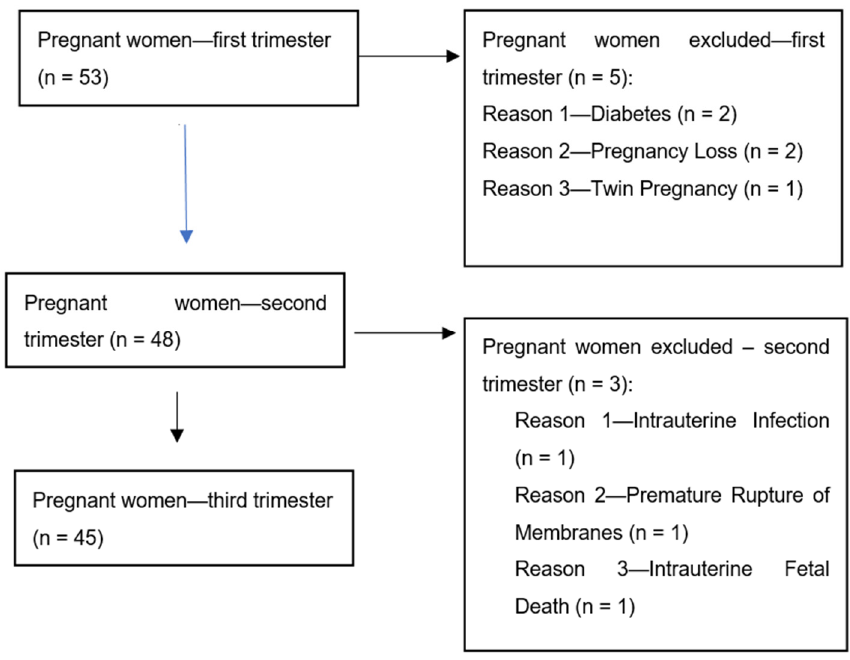
Figure 1. Flow chart showing the pregnant women from the control group that were included and excluded from the study. Table 1. The clinical and laboratory characteristics of pregnant patients with PE (n = 35) and women in normal pregnancy (n = 45).